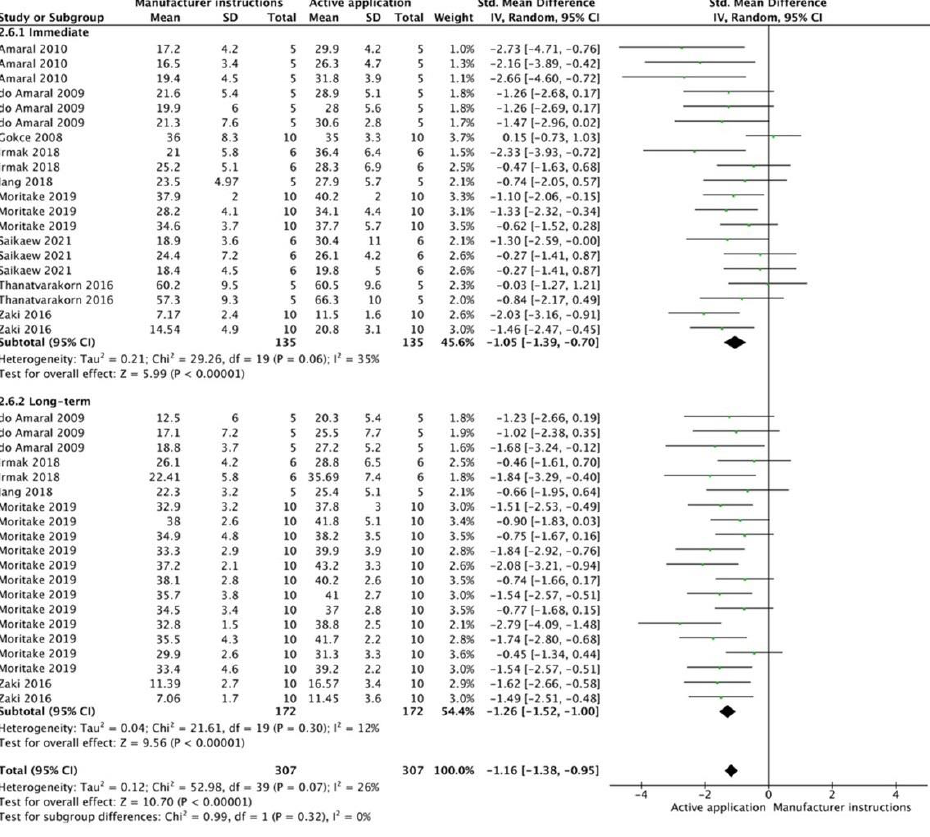
Figure 12. Forest plot showing the bond strength values when the adhesive was used in an active application [86,87,109,114–119].